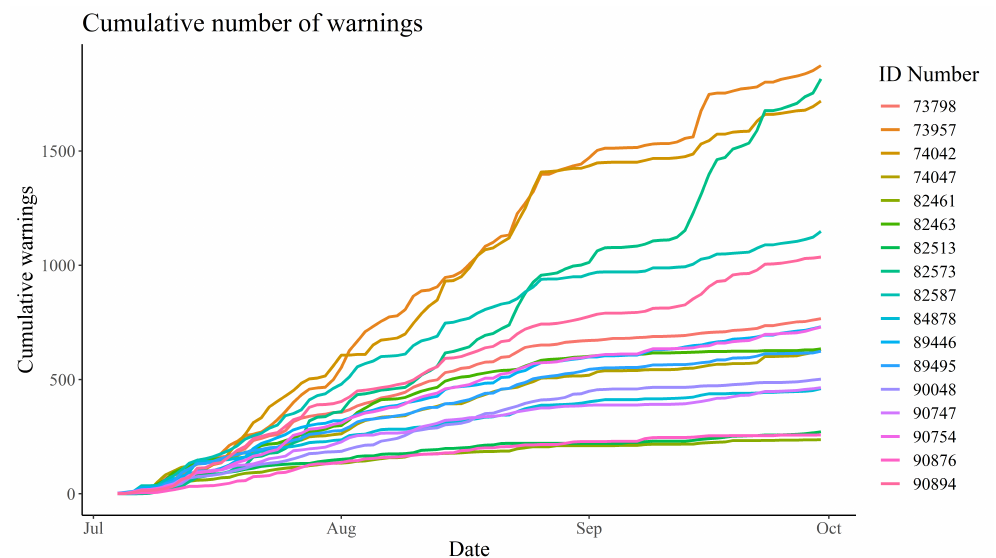
Figure 4. Cumulative number of warnings received by each bull calf between 4 July 2022 and 30 September 2022. The ID Number refers to each of the 17 calves.